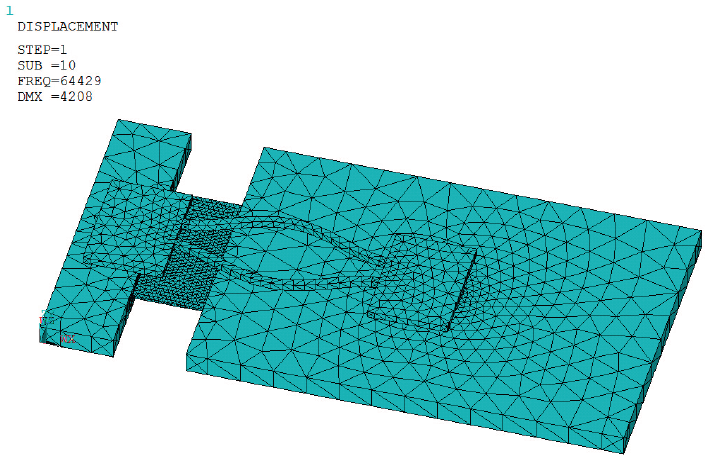
Figure 4. Simulated ninth order in plane anti phase vibration